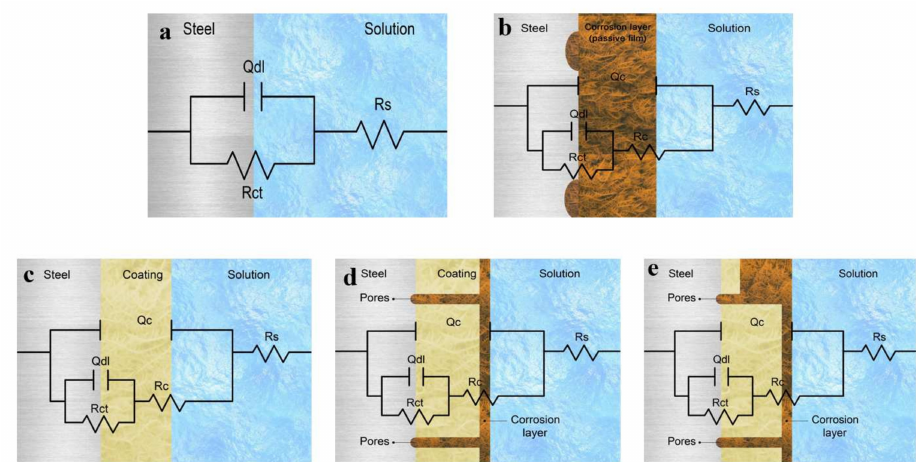
Figure 7. Electrochemical equivalent electric circuit models obtained from fitting the impedance data: ( a ) bare steel before corrosion, ( b ) corroded bare steel, ( c ) coated steel, ( d ) enhanced corrosion resistance, and ( e ) decreased corrosion